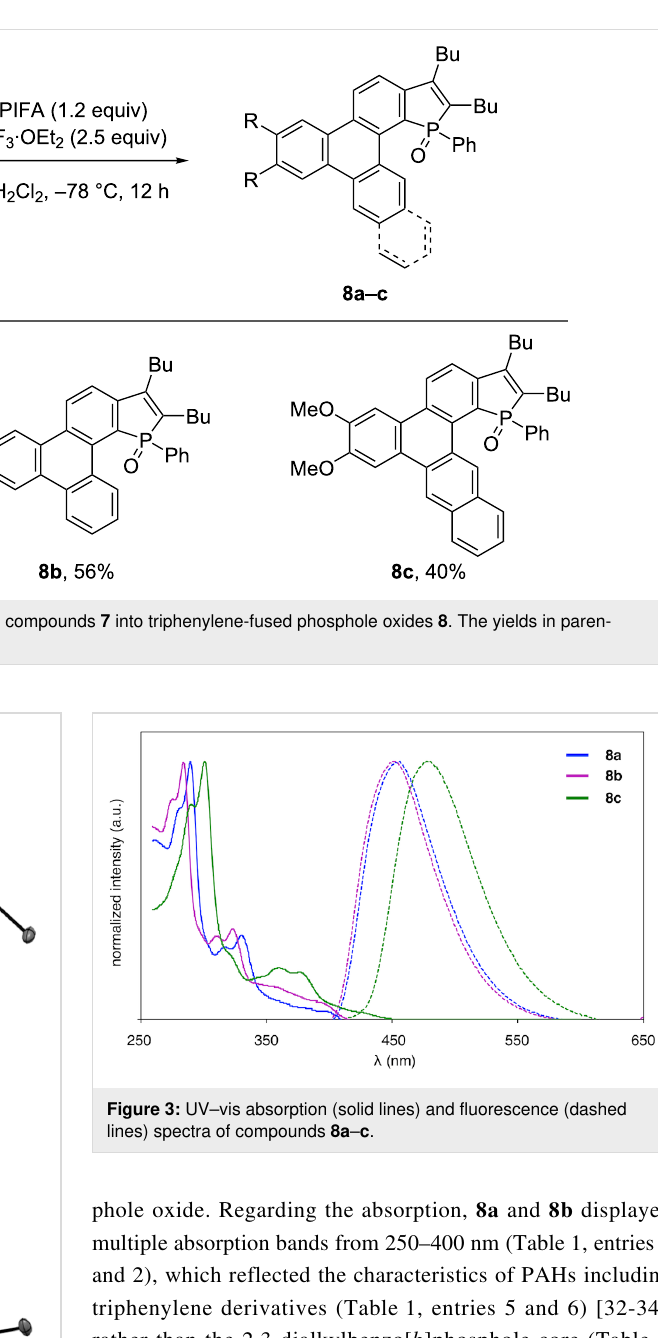
Table 1 provides a summary of these spectra and reported spec- tral data of structurally related benzo[ b ]phosphole and tri- phenylene derivatives. The optical data illustrate the nature of compounds 8a – c as hybrids of triphenylene and benzo[ b ]phos-